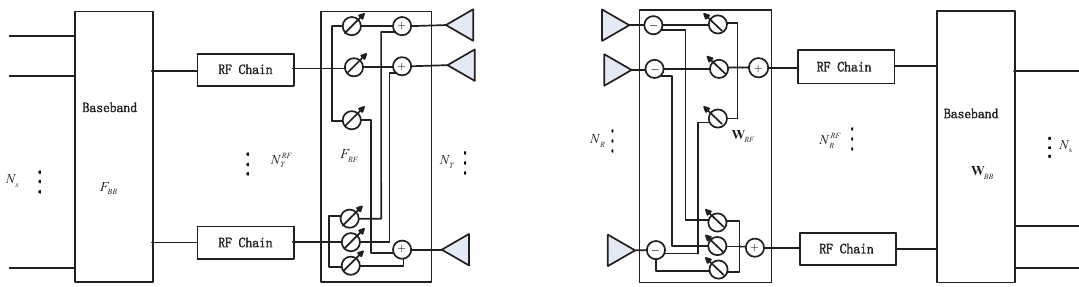
Figure 1. Illustration of a hybrid MIMO architecture with the fully connected phase shifting